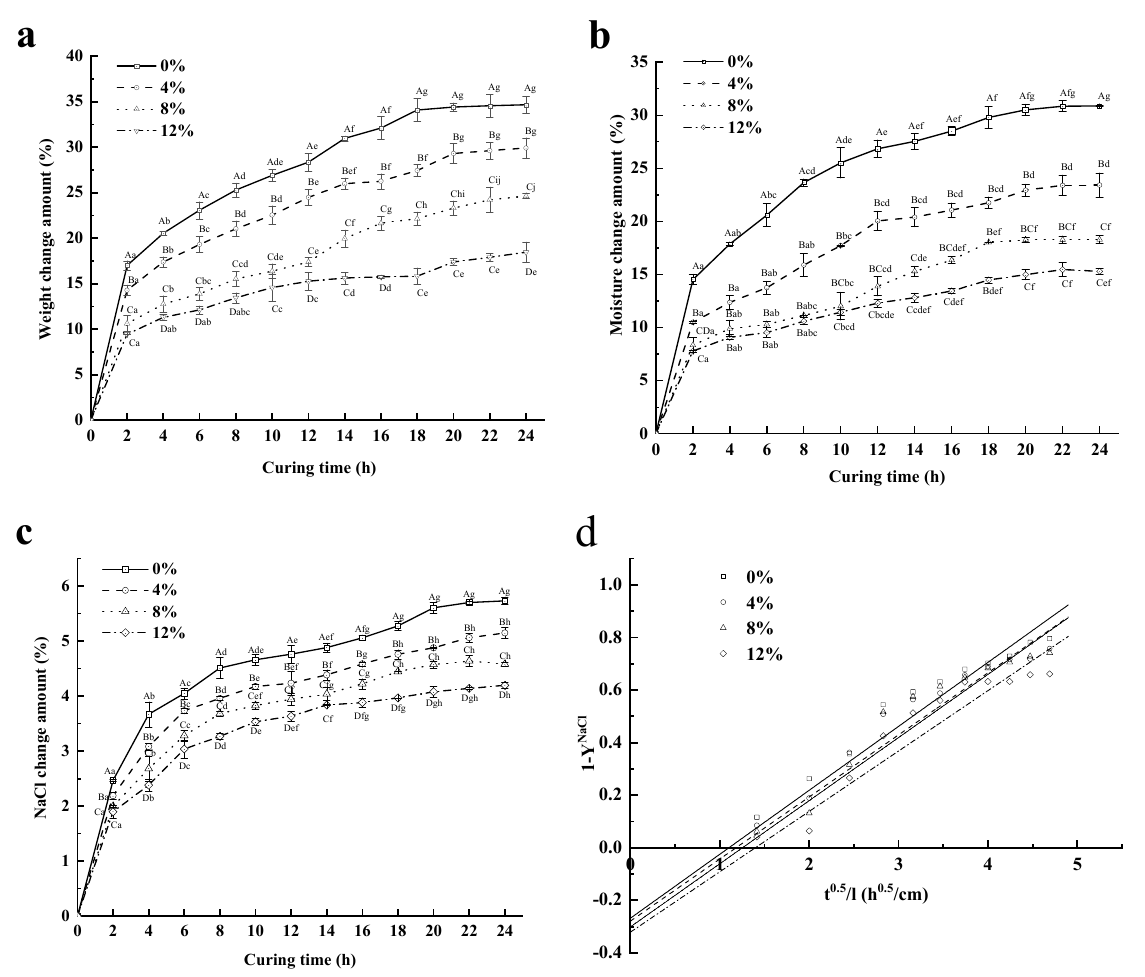
Figure 1. The weight change amount ( a ), moisture change amount ( b ), and NaCl change amount ( c ) of pork tenderloin with different xylitol concentrations, and driving force (1 − Y tNaCl ) versus curing time (t 0.5 /l) ( d ). Note: different capital letters indicate significant differences between the treatment groups with different concentrations of xylitol ( p < 0.05); different small letters indicate significant differences between the treatment groups with different curing processes ( p < 0.05).